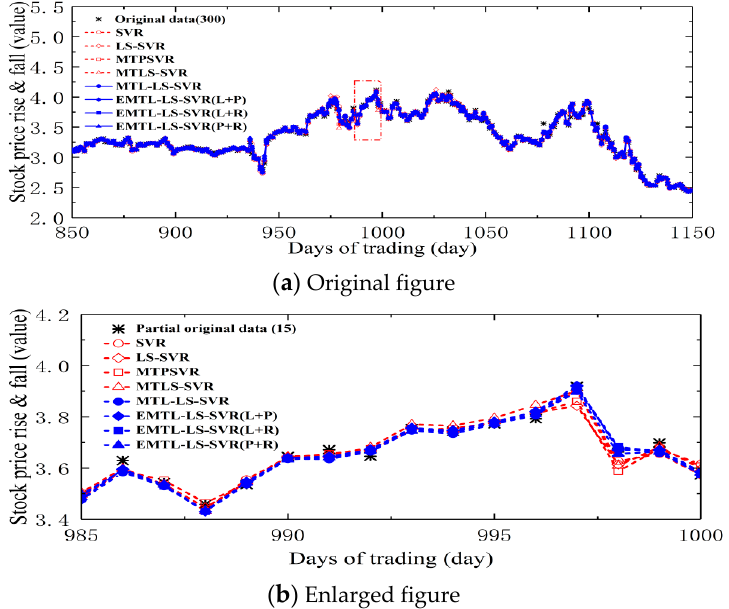
Figure 10. Predictions of different regression models on stock opening price for ABC ( a ) Original figure, ( b ) Enlarged figure.